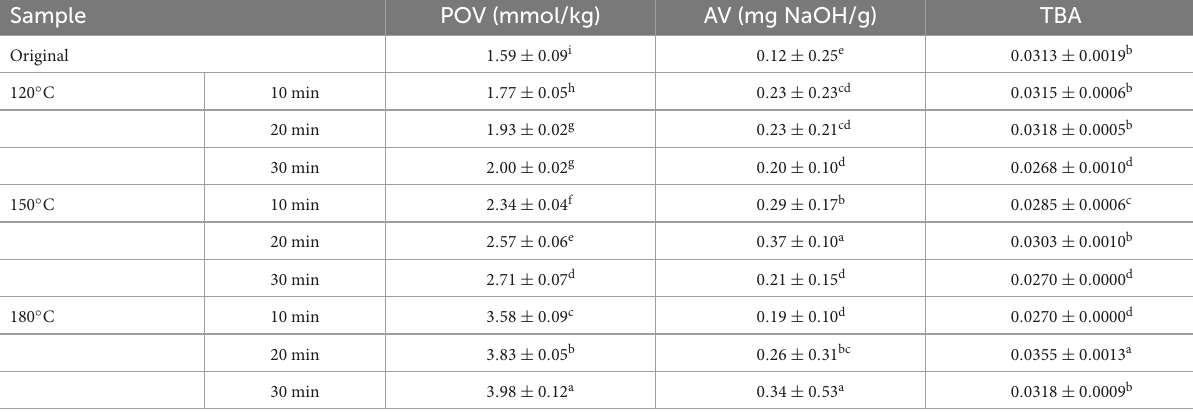
TABLE 2 Peroxide value, acid value, and thiobarbituric acid of walnut oil by roasted walnut kernels with different temperature and duration. Sample